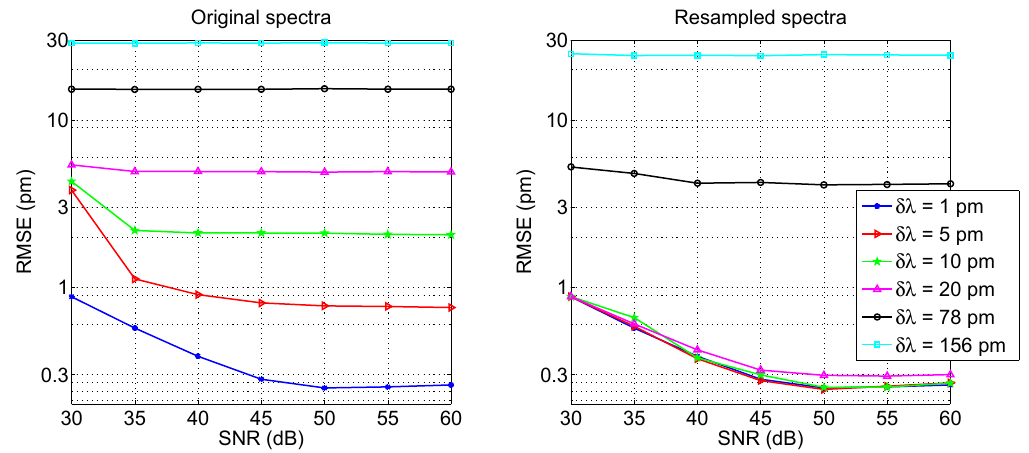
Figure 17. Performance analysis of X-BW peak tracking technique: the RMSE on peak detection is reported as a function of SNR, for different values of sampling grid δλ (1 pm, 5 pm, 10 pm, 20 pm, 78 pm, 156 pm). ( Left ) FBG spectra are processed without resampling. ( Right ) FBG spectra have been resampled, on a new grid with δλ R = 1 pm (corresponding to Q = δλ /(1 pm)). Threshold: X = 3dB.